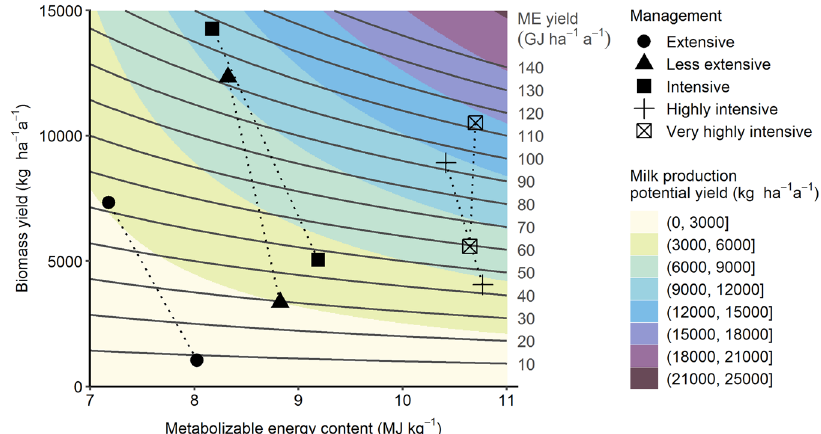
Fig. 1 Recalculated milk production potential yield. Milk production potential yield (shading) and metabolizable energy (ME) yield (solid lines) as a function of biomass yield and forage metabolizable energy content. Symbols connected by dotted lines represent mean values of the 1-species plots (lower biomass yield) and 60-species plots (higher biomass yield) under the different management treatments as reported in ref. 14 .